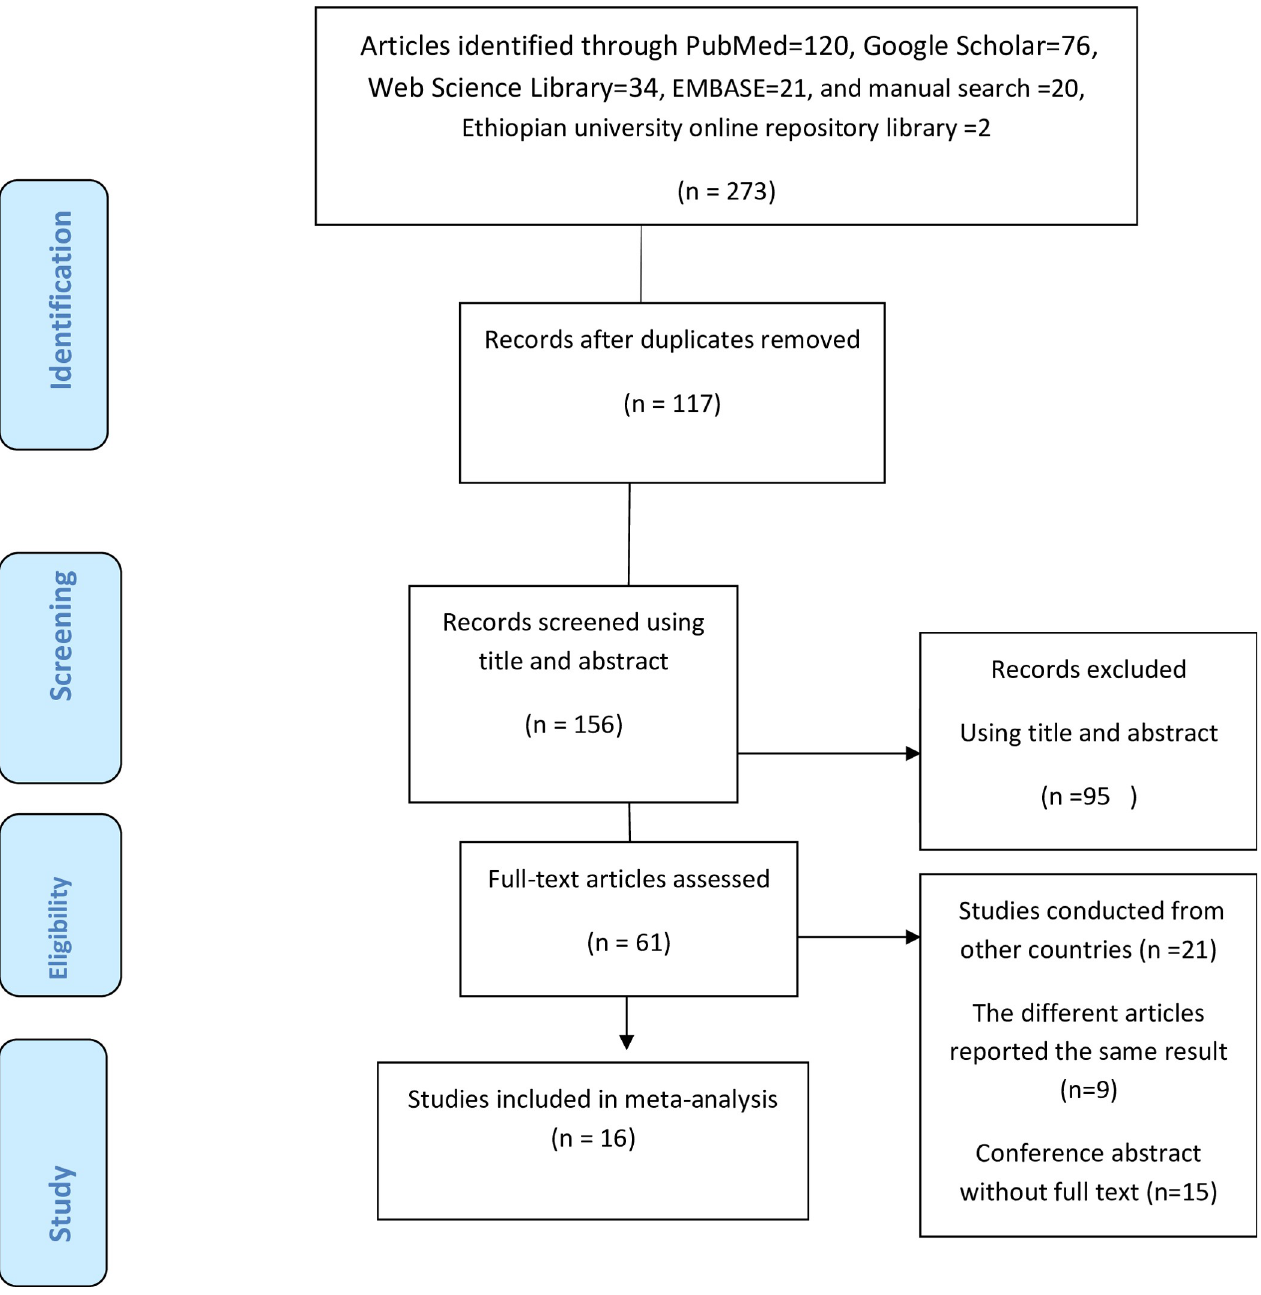
Fig 1. A Prisma diagrammatic presentation used to show the selection of studies. The inclusion criteria were variation of the title and abstracts, place of study (Ethiopia), presence of full abstract, and reporting different results. Studies were excluded if they criteria were duplicated source, unrelated research, case studies and qualitative